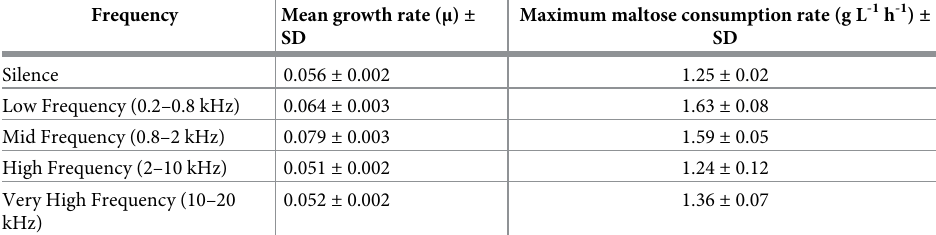
Table 3. Effects of sound frequency on specific growth rates and maximum maltose consumption rates of S . cere- visiae